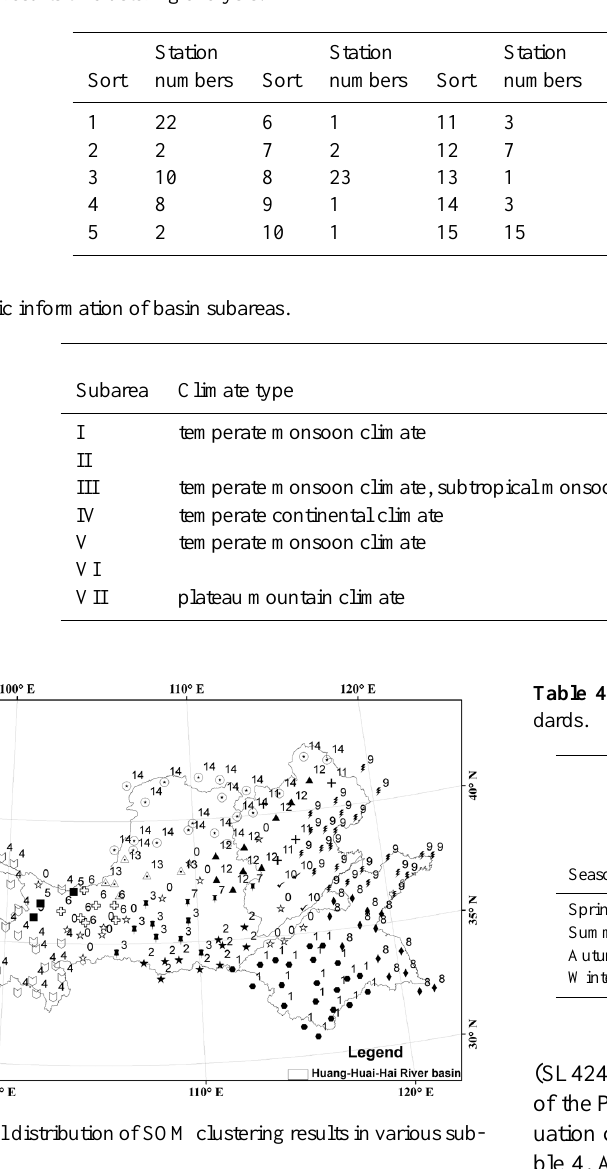
Table 2. The results of clustering analysis.